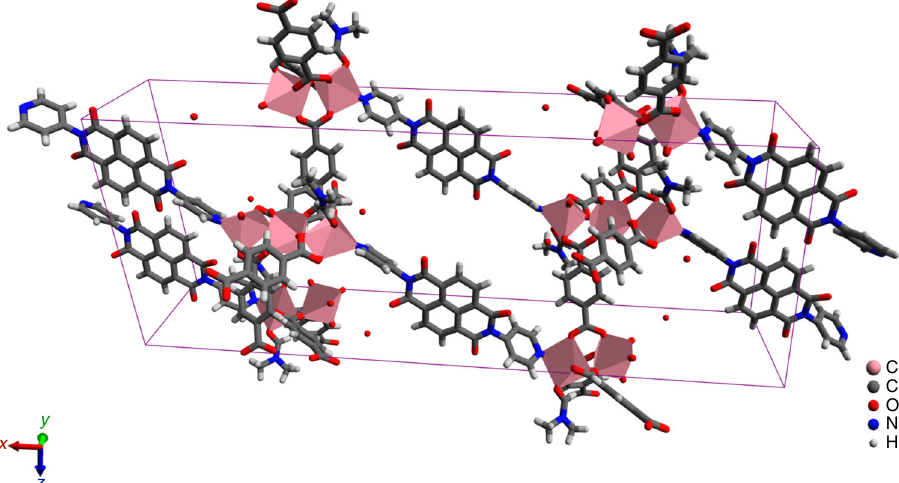
Fig. 1 A representation of MOF-CoNDI-py-2 crystal structure including its unit cell obtained by single-crystal XRD. Pink = cobalt, grey = carbon, white = hydrogen, blue = nitrogen and red = oxygen. The unit cell belongs to a C 2/ c monoclinic space group, water was modelled at 1/4 occupancy and its hydrogens are not shown for clarity. The structure shows the NDI-py molecules oriented in a layered fashion. The distances between NDI-py entities are 9.43 Å along the c -axis, 9.57 Å along the b -axis and 11.10 Å through the metal